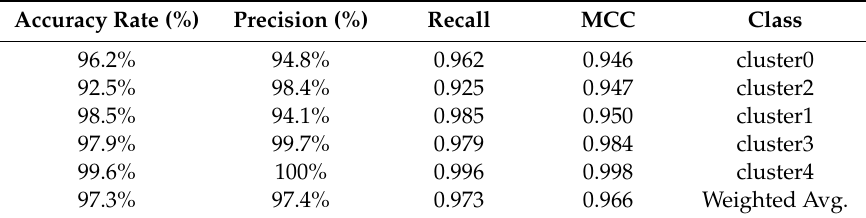
Table 4. Logistic regression prediction for electron 1 based on segmented EEG.